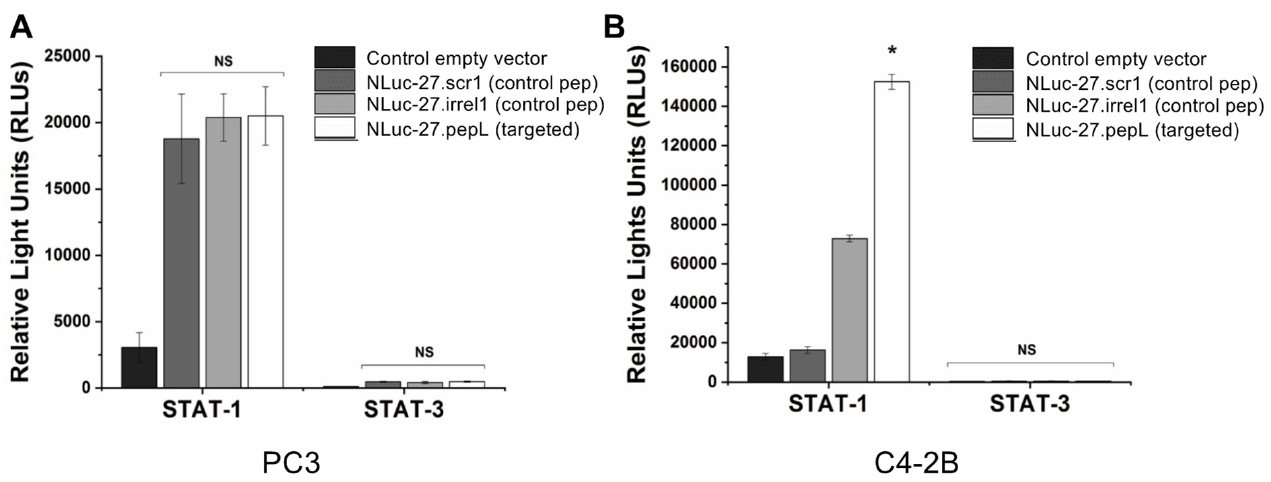
Figure 7. STAT-1 and STAT-3 activation in PC3 and C4-2B prostate ‘cancer-cell’ models following treatment with Nluc-27-conditioned media. ( A ) Treatment with targeted Nluc-27pepL in PC3 cells induced STAT-1 activation in response to targeted (pepL) and non-targeted Nluc-27 (Scr-1, Irrel-1), with minimal activation of STAT-3 (non-significant, ns). ( B ) Treatment with targeted Nluc-27pepL in C4-2B cells induced a 12-fold in STAT-1 activation relative to control vector, with no significant changes (ns) in STAT-3 expression in response to treatment with Nanoluc-27 (targeted or non-targeted). Data are presented as mean ± SEM. Comparisons within cell types were performed using one-way ANOVA. A p -value < 0.05 indicates a significant difference (*).